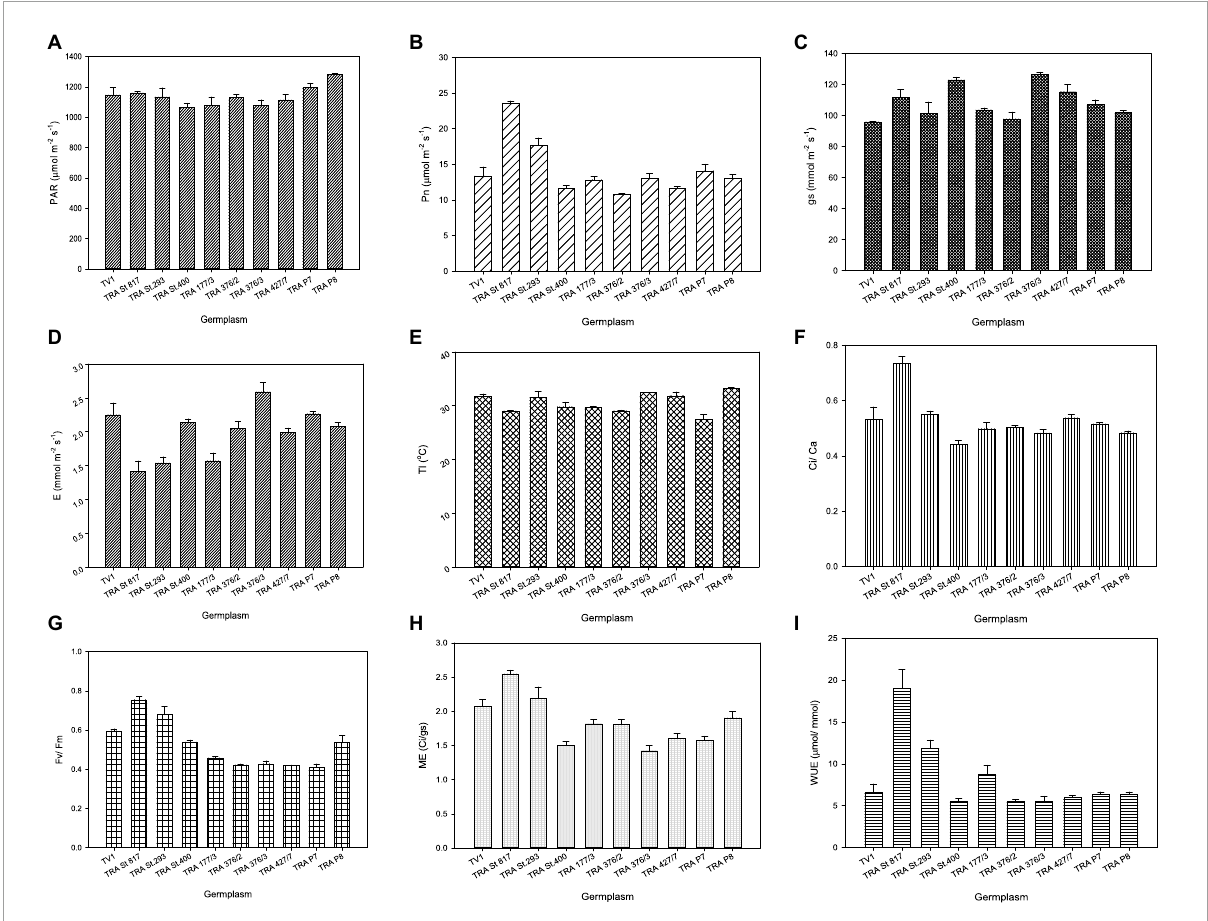
FIGURE1 Physiological responses of tea germplasm with respect to (A) light (PAR), (B) net photosynthesis (Pn), (C) stomatal conductance (Gs), (D) evaporation (E), (E) leaf temperature (Lt), (F) carboxylation efficiency (ci/ca), (G) chlorophyll fluorescence (fv/fm), (H) mesophyll efficiency (ME), (I) water-use efficiency (WUE). Vertical bars indicate the standard error of